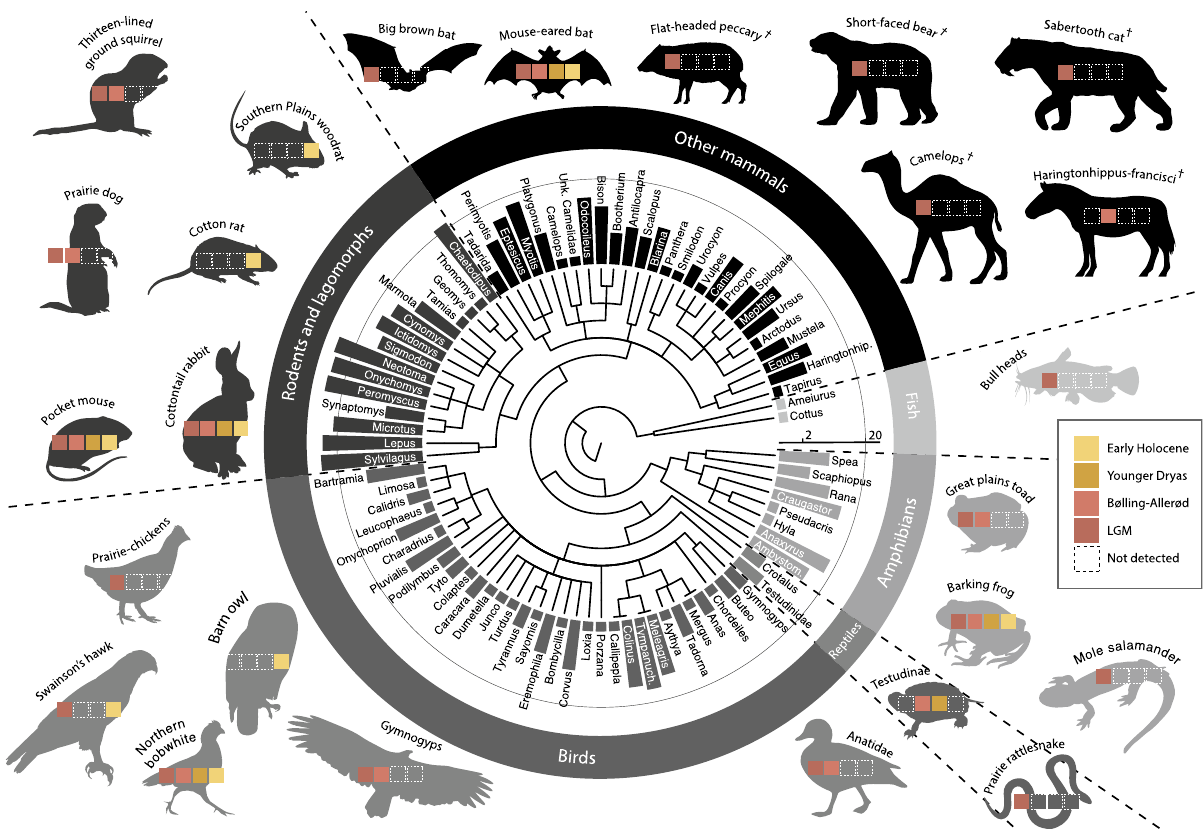
Fig. 2 Overall vertebrate diversity derived from bulk-bone metabarcoding (BBM). Dendrogram of genera detected by BBM at Hall ’ s Cave (Texas), with silhouettes illustrative of some of the detected taxa. Bar heights represent the number of bulk-bone layers ( n = 36) in which each genus was detected. See Supplementary Tables 6 – 8 for a complete list of taxa detected. Daggers highlight extinct